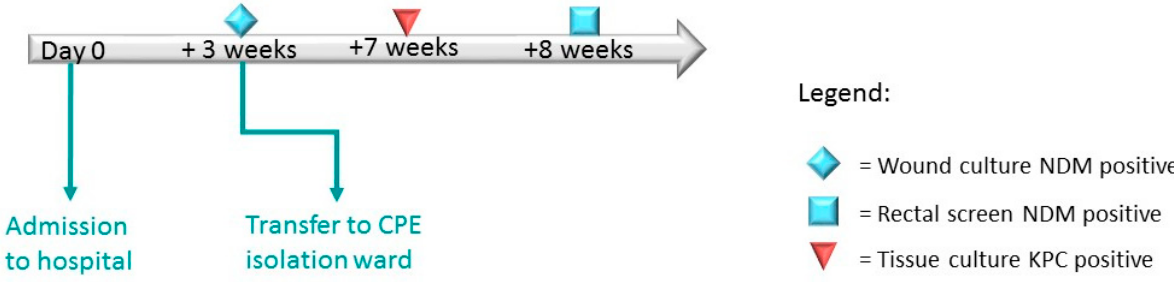
Figure 2. Epidemiological timeline of Case Study 2: patient’s CPE acquisition and screening results from period of hospitalization. All CPE detection performed by NCIC laboratory. Table 2. Summary of results of CPE-positive bacteria isolated during routine CPE screening in Case Study 2.